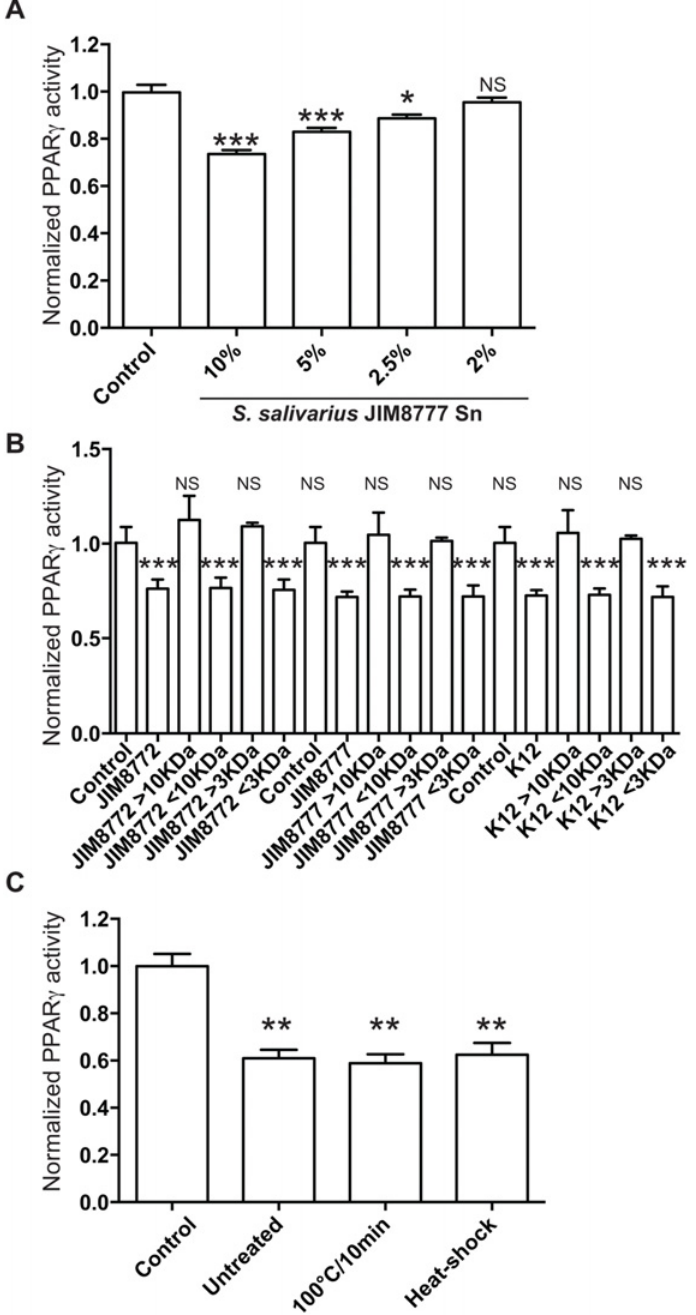
Fig 4. Determination of the nature and molecular mass of the secreted bioactive compounds. A- Serial dilutions of S . salivarius JIM8777 supernatant were tested on HT-29-PPAR γ cells prior to activation with sodium butyrate (2mM). B- Exposure to high temperature (100°C/10 min) and heat shock were applied to S . salivarius JIM8777 supernatant prior to addition to activated HT-29-PPAR γ cells. C- Butyrate-activated HT- 29-PPAR γ cells were incubated with S . salivarius supernatants fractions derived from ultrafiltration through 3 and 10 kDa cutoff membranes. > 10kDa/ > 3kDa and < 10kDa/ < 3kDa represent the retained and filtered fractions respectively. Data are expressed as means ± standard deviations (SD) of triplicate measurements from one representative experiment out of three independent experiments. *** P < 0.001, ** P < 0.005, * P < 0,05 compared with controls (Student's